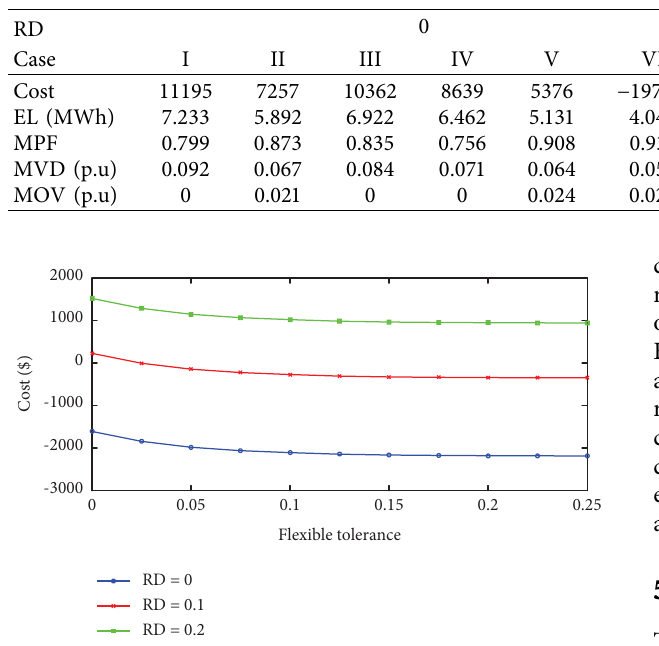
Figure 8: Curve of cost in Δ F in diferent values of